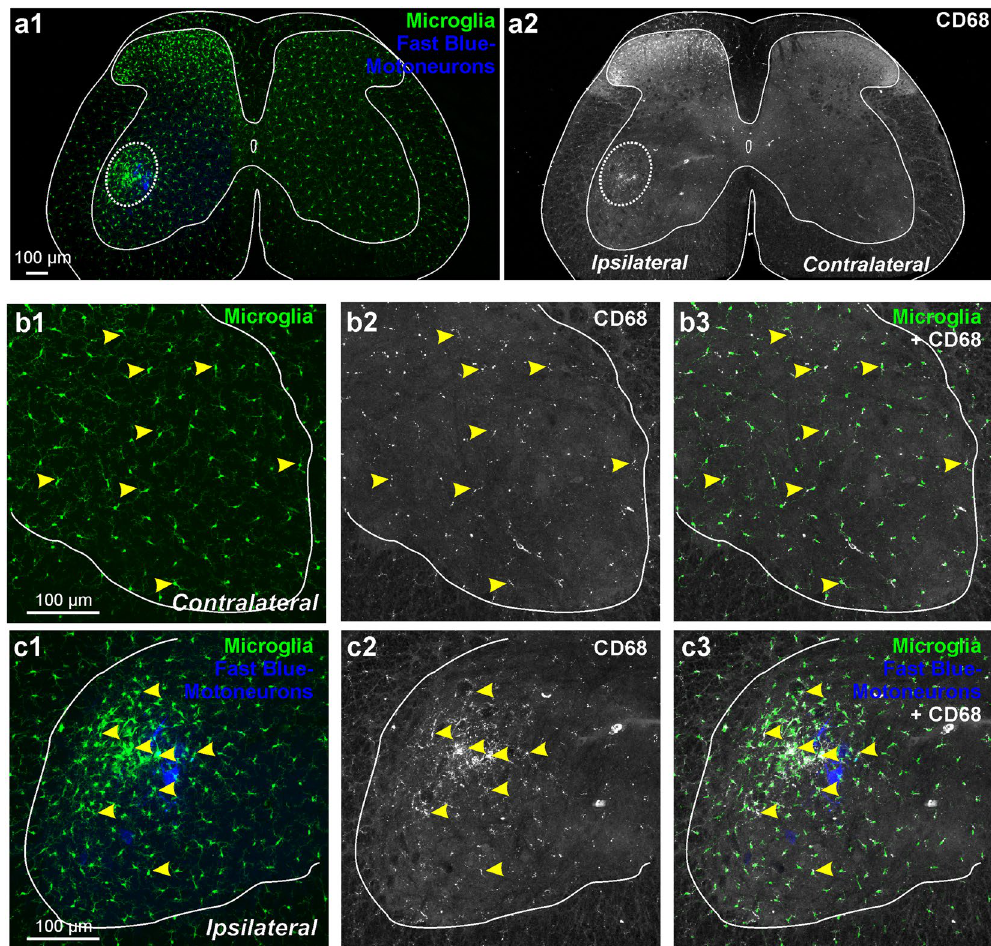
Figure 1. CD68 in mouse spinal microglia 14 days after injury. ( a1 ) Low magnification confocal image of CX3CR1-GFP microglia in the spinal cord of an animal with an unilateral sciatic nerve lesion. Motoneurons ipsilateral to a sciatic nerve injury were retrogradely labeled with Fast Blue (FB). Microglia show increased numbers in the superficial laminae of the dorsal horn ipsilateral to the injury and around axotomized motoneurons in the ventral horn (dashed ellipse). ( a2) CD68 immunoreactivity in the same section as in a1. CD68 is upregulated in dorsal and ventral regions showing microgliosis. ( b ) Higher magnification confocal image of the control side ventral horn showing CX3CR1-GFP microglia ( b1 ), CD68 ( b2 ) and superimposition of both ( b3 ). CD68 is contained within CX3CR1-GFP microglia (arrowheads). ( c ) Confocal images of the ventral horn ipsilateral to the nerve injury and containing FB motoneurons and CX3CR1-GFP microglia ( c1 ), CD68 ( c2 ) and superimposition of both ( c3 ). CD68 is upregulated in microglia around axotomized motoneurons